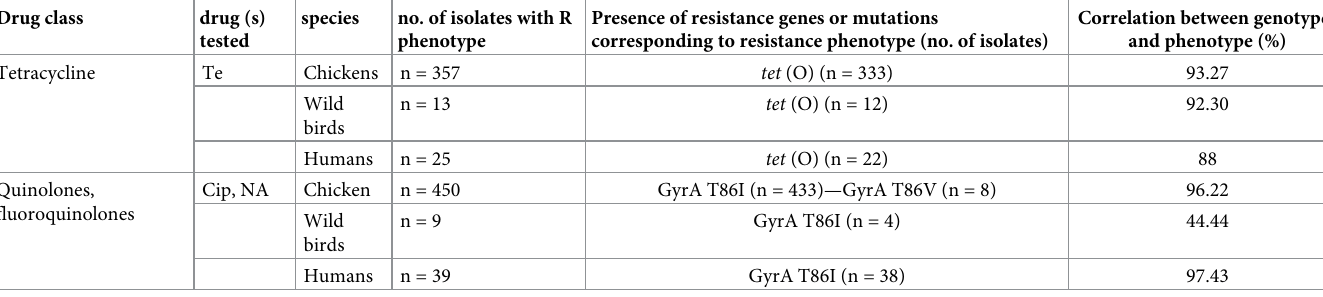
Table 4. Correlations between resistance phenotypes and genotypes among C . jejuni isolates. Drug class drug (s)